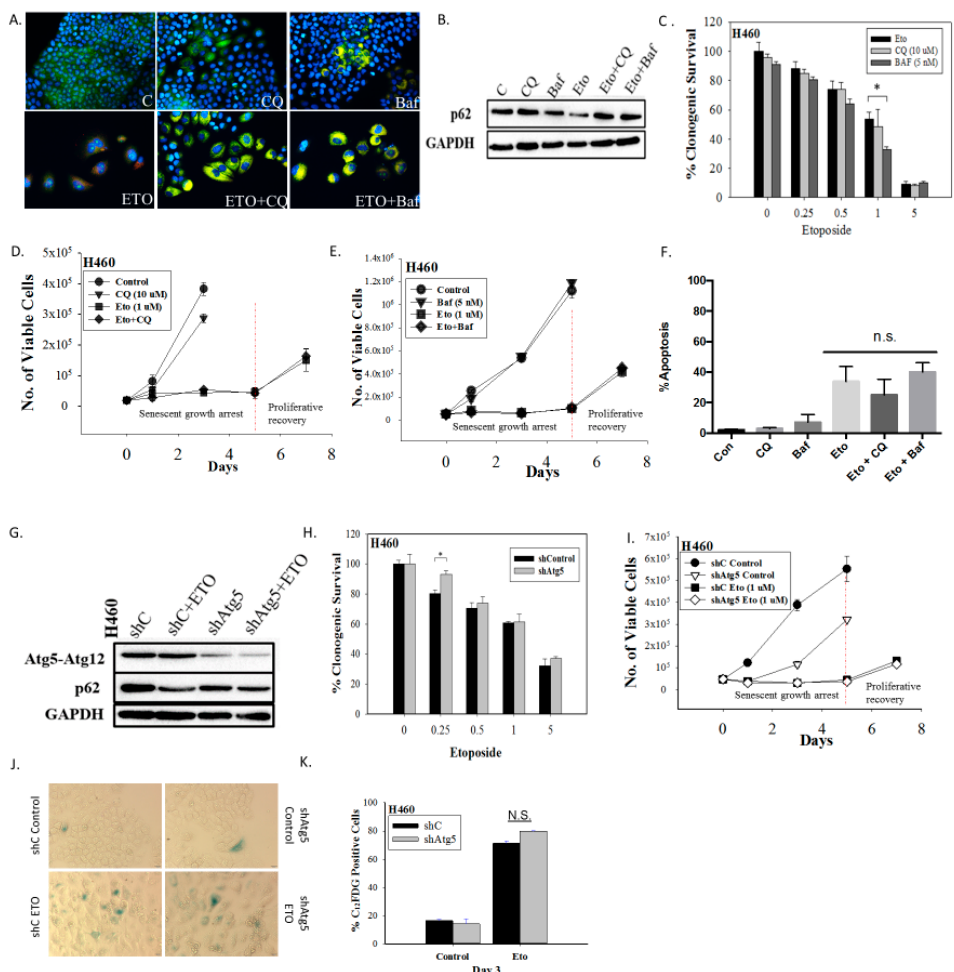
Figure 2. Inhibition of autophagy does not interfere with the induction or the recovery from senescence in H460 cells exposed to etoposide. ( A ) Fluorescence microscopy showing failure of lysosomal acidification following chloroquine (CQ, 10 µ M) or bafilomycin A1 (Baf, 5 nM) co-treatment with etoposide (ETO, 1 µ M). Cells were pretreated with CQ and Baf followed by an additional 24 h with etoposide. Images were taken 48 h after drug removal. Nuclei stained with Hoechst 33342 (20x objective). ( B ) Western blot showing autophagy blockade by CQ (10 µ M) and Baf (5 nM) based on levels of p62 / SQSTM1 ( C ) Clonogenic survival assay showing influence of CQ (10 µ M) or Baf (5 nM) on sensitivity of H460 cells to etoposide. Cells were pretreated with CQ or Baf for 3 h followed by co-treatment with etoposide for 24 h. Colonies were counted 7 days following removal of drugs and replacement with fresh medium. Bars represent mean survival ± SD relative to untreated controls ( α = 0.05 / 3, * p < 0.016). ( D ) and ( E ) Temporal response to etoposide in H460 cells after pharmacological autophagy inhibition. Viable H460 cell number was determined at the indicated days following etoposide exposure in combination with 10 µ M CQ (D) or 5 nM Baf ( E ). ( F ) Assessment of apoptosis 48 h after drug removal (n.s. = no significant di ff erence). ( G ) Western blot following short hairpin RNA (shRNA)-mediated knockdown of Atg5. ( H ) Clonogenic survival assay comparing sensitivity of shControl and shAtg5 H460 cells in response to multiple etoposide concentrations. Bars represent mean survival ± SD relative to untreated controls ( α = 0.05 / 3, * p < 0.016). ( I ) Temporal response to etoposide in shControl H460 cells and H460 cells with knockdown of Atg5. ( J ) Etoposide-induced senescence in both autophagy-proficient and autophagy-deficient H460 cells by staining for SA- β -gal activity (20x objective). ( K ) Percent senescence based on C 12 FDG staining at day 3 post-etoposide exposure in shControl cells and shAtg5 cells. Results presented were from three independent experiments unless otherwise